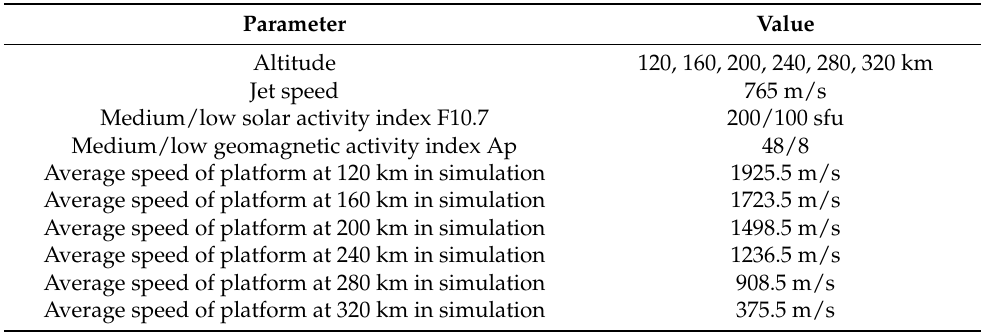
Table 3. Simulation parameters.